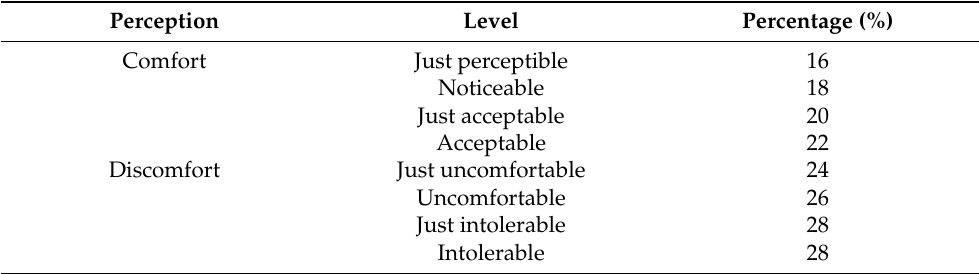
Table 4 . Daylight Glare Index (DGI) scaling according to different levels.